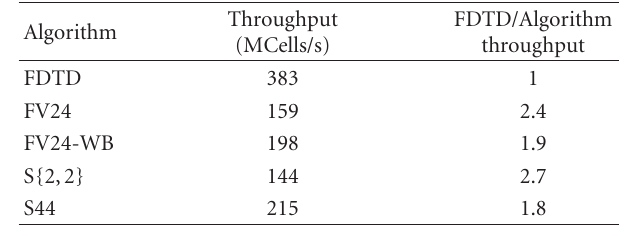
Table 4: Comparison of GPU kernels’ throughputs for the various FDTD algorithms.